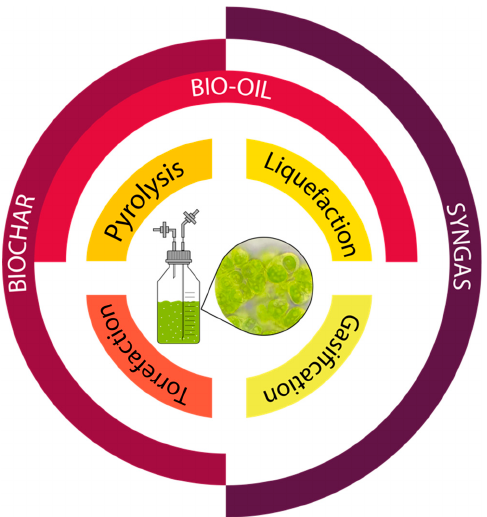
Figure 2. Different thermochemical conversion methods of microalgal biomass and their main products.